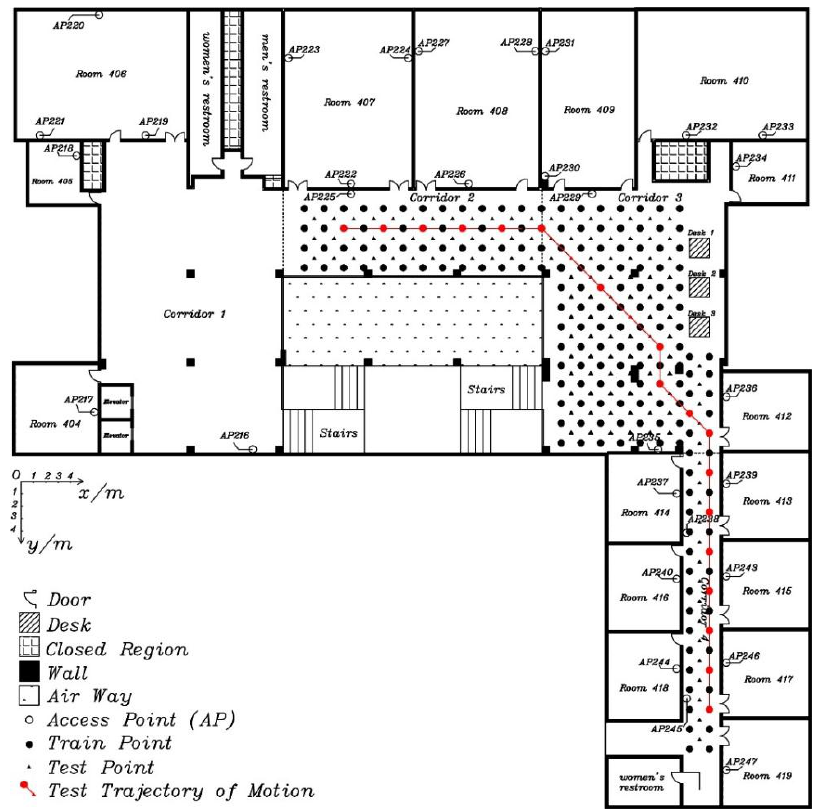
Figure 9. The layout of the experimental area.